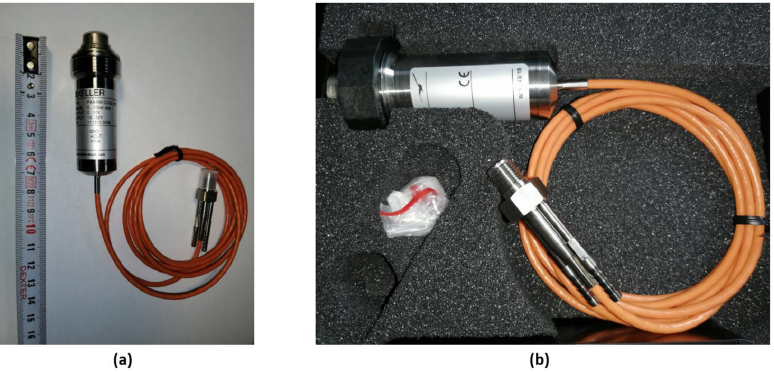
Figure 11. The pressure sensors: ( a ) Keller M8coolHB, ( b ) Kistler 4049A10.